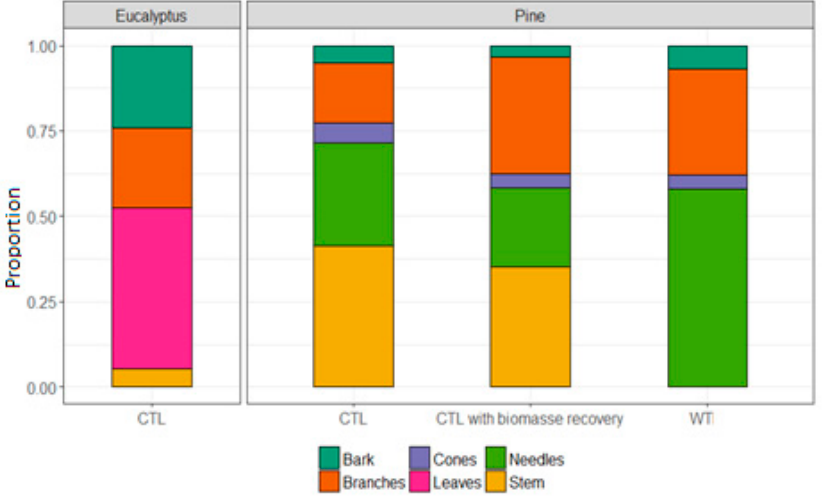
Figure 3. Relative proportion of biomass components.